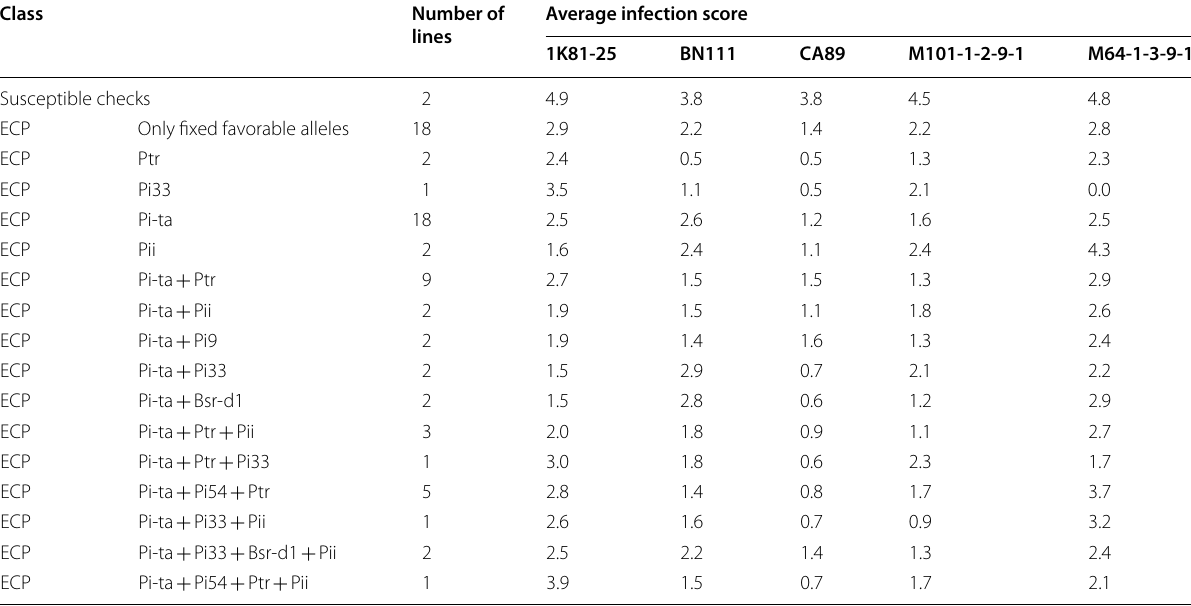
The disease scores (from 0 (resistant) to 5 susceptible) are categorized by isolate and grouped by allele classes for known resistance genes. Five different isolates of Magnaporthe oryzae were